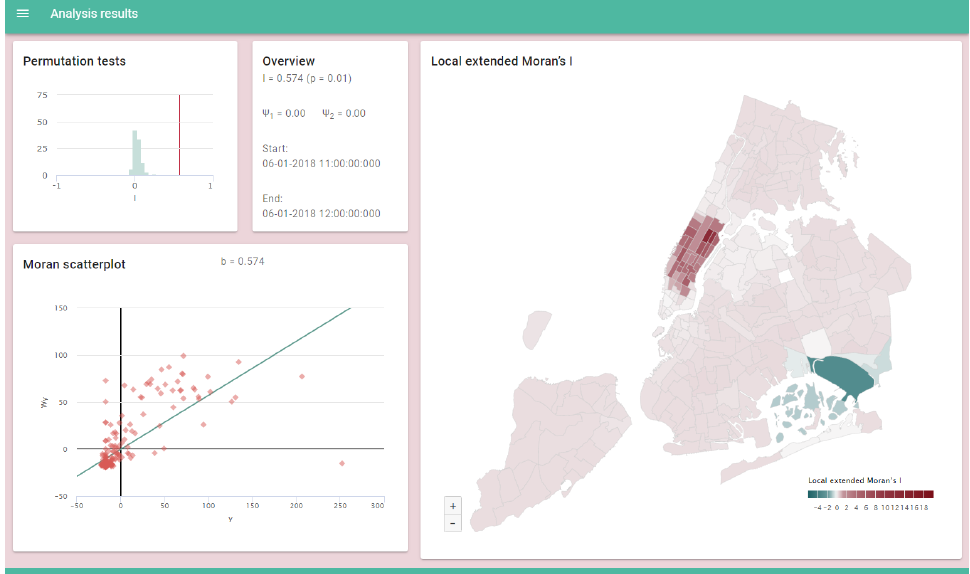
Figure 5. Structure of the result dashboard.